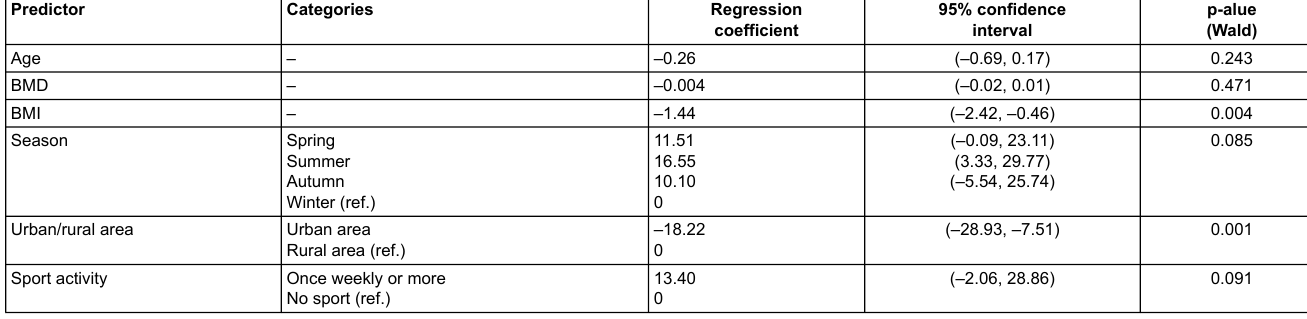
Table 7: Multiple linear regression model for serum 25(OH)D (nmol/l) at first visit.